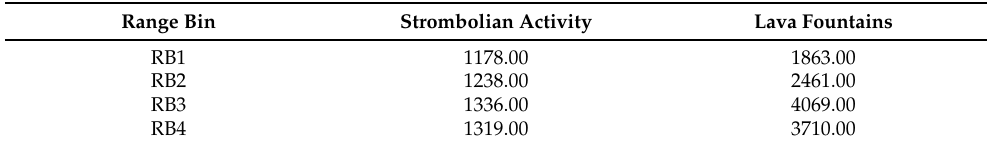
Table 3. Reference values for the Strombolian activity and lava fountains; they were obtained by averaging the starting values for both volcanic phenomena of all the 23 eruptive episodes (shown in Figure